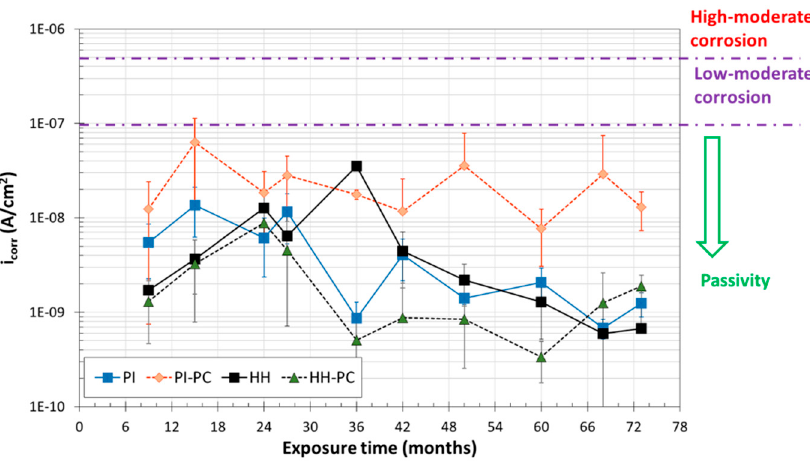
Figure 7. Corrosion rate (i corr ) values calculated from EIS experiments for S32304 steel under di ff erent testing conditions.